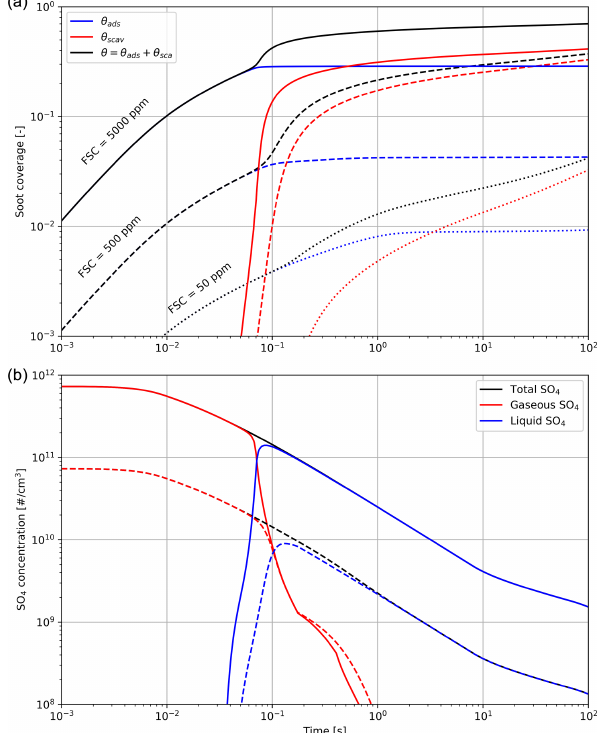
Figure 3. Black carbon fractional coverage (a) and number density of H 2 SO 4 molecules (b) , in gas and liquid form, as a function of time after emission. The total black carbon fraction coverage θ is the sum of the adsorption and scavenging contributions. Different line styles correspond to different fuel sulfur content (50, 500 and 5000ppm).